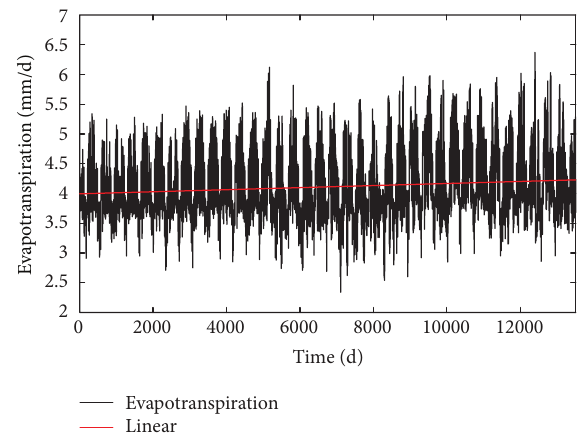
Figure 3: Areal daily evapotranspiration calculated with the Priestley-Taylor method from 1978 to